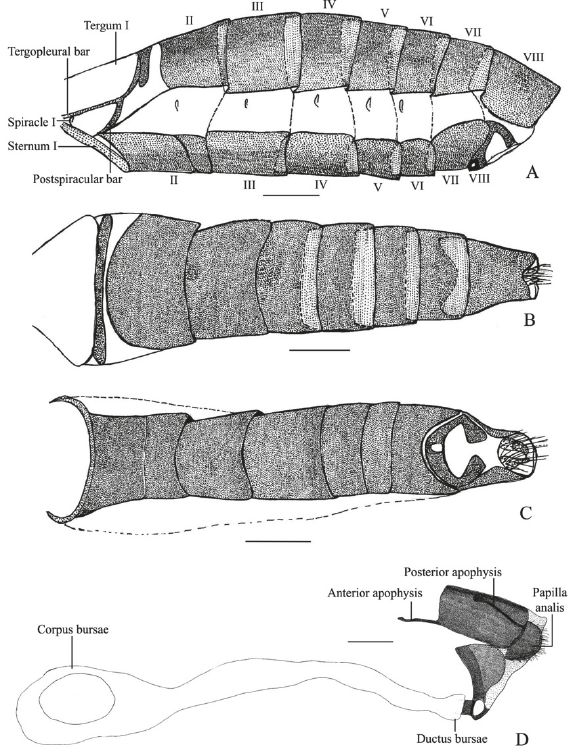
Figure 15. Female genitalia of Junonia hierta (Fabricius, 1798) A – C - abdomen (lateral, dorsal and ventral view); D - female genitalia (lateral view). Scale bar